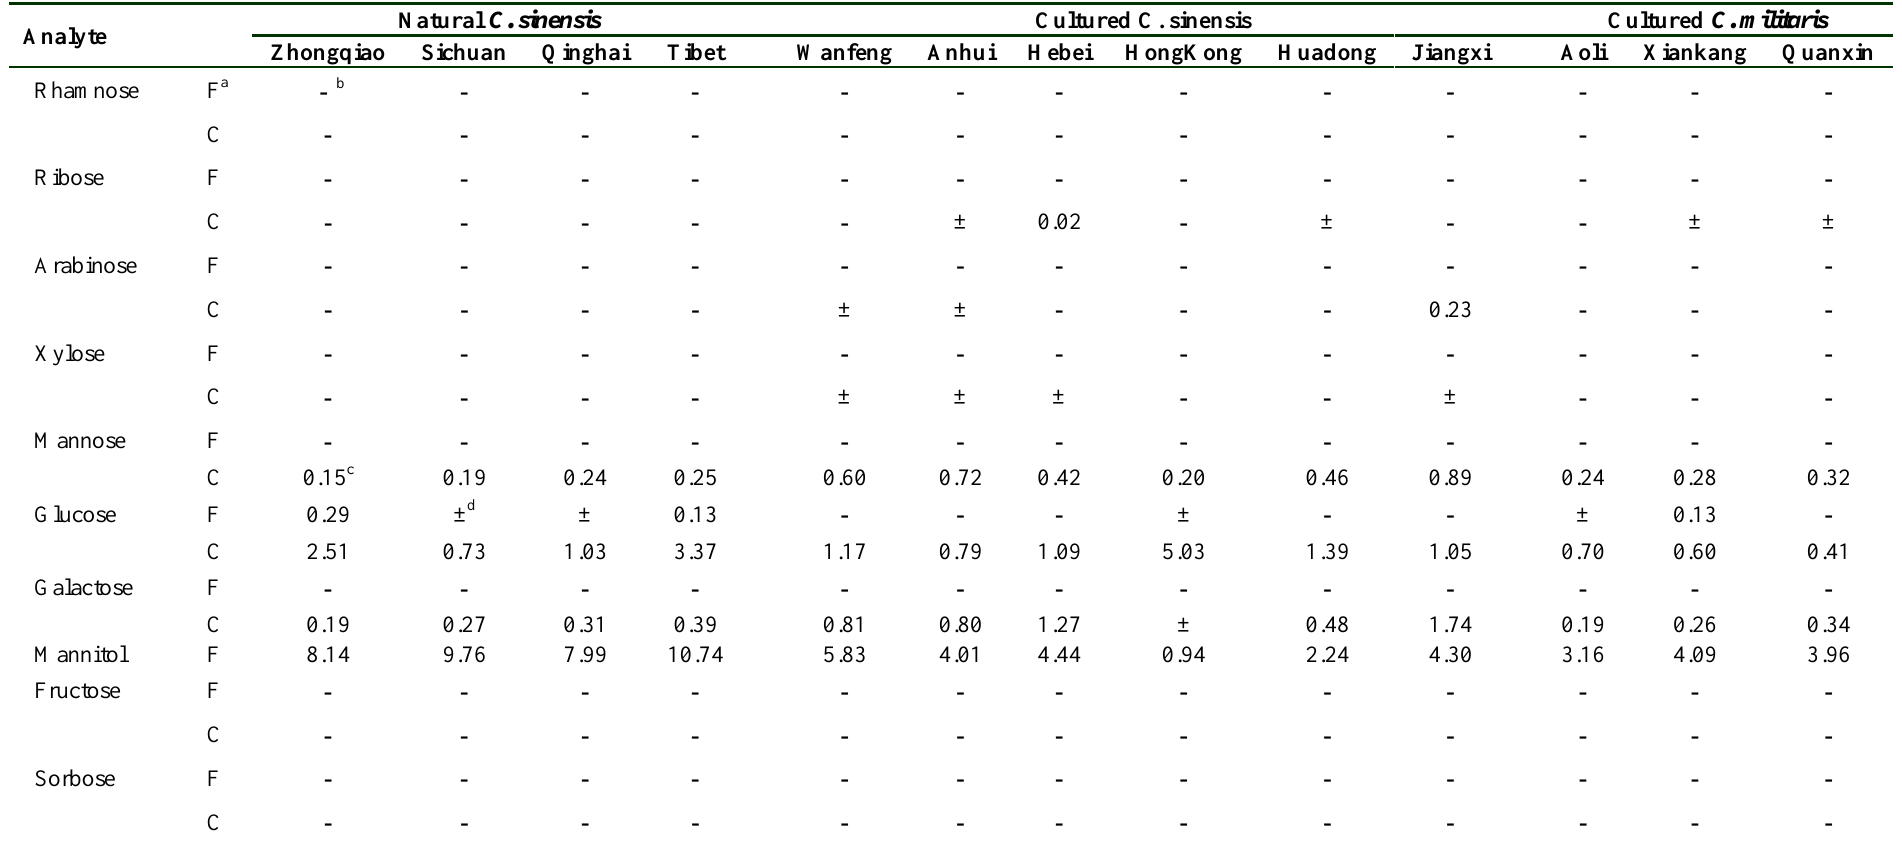
Table 5. Contents of free and conjunct carbohydrates (mg per 100 mg) in natural and cultured Cordyceps . Analyte